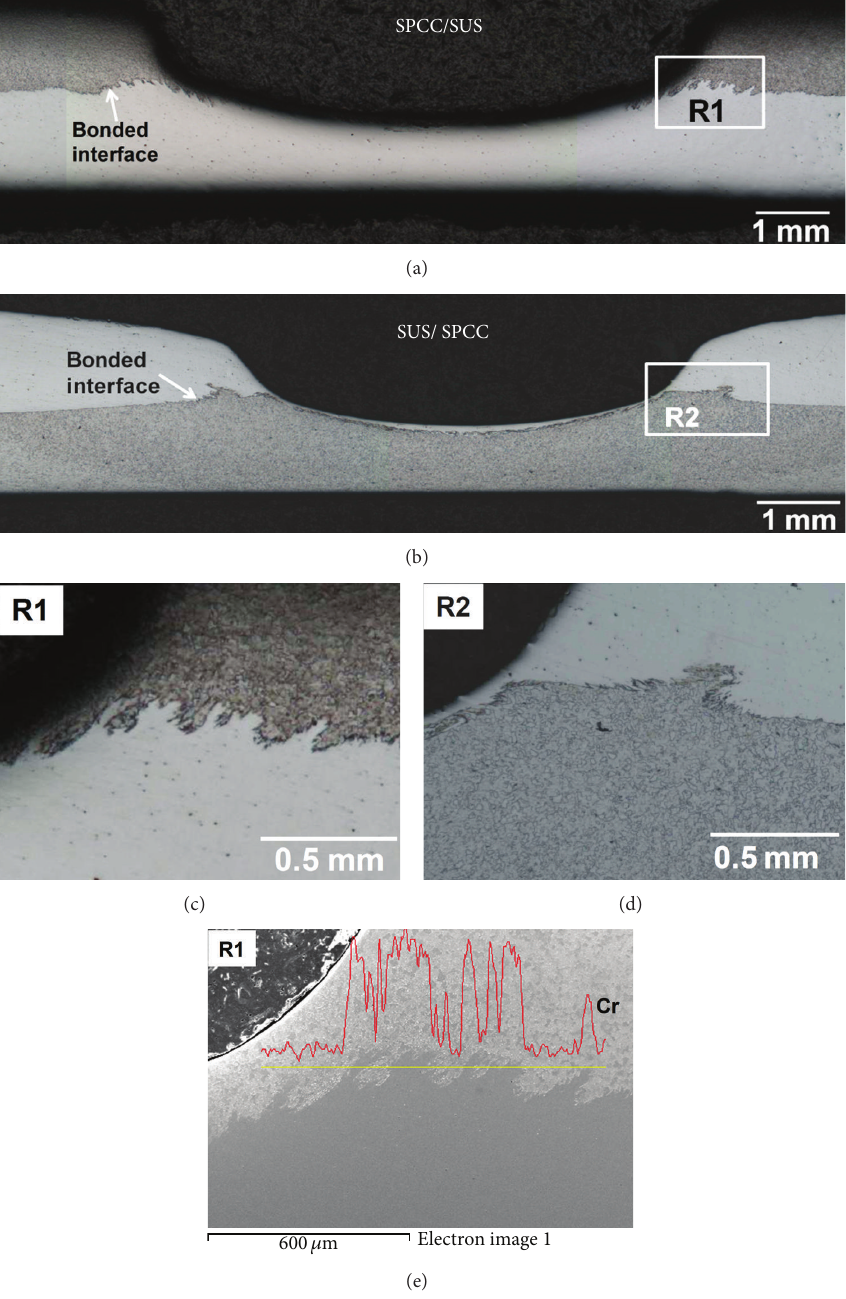
Figure 4: Optical micrographs of (a) SPCC/SUS and (b) SUS/SPCC FSSW joints; (c) region R1 in (a) and (d) region R2 in (b); (e) Cr distribution profile in region R1